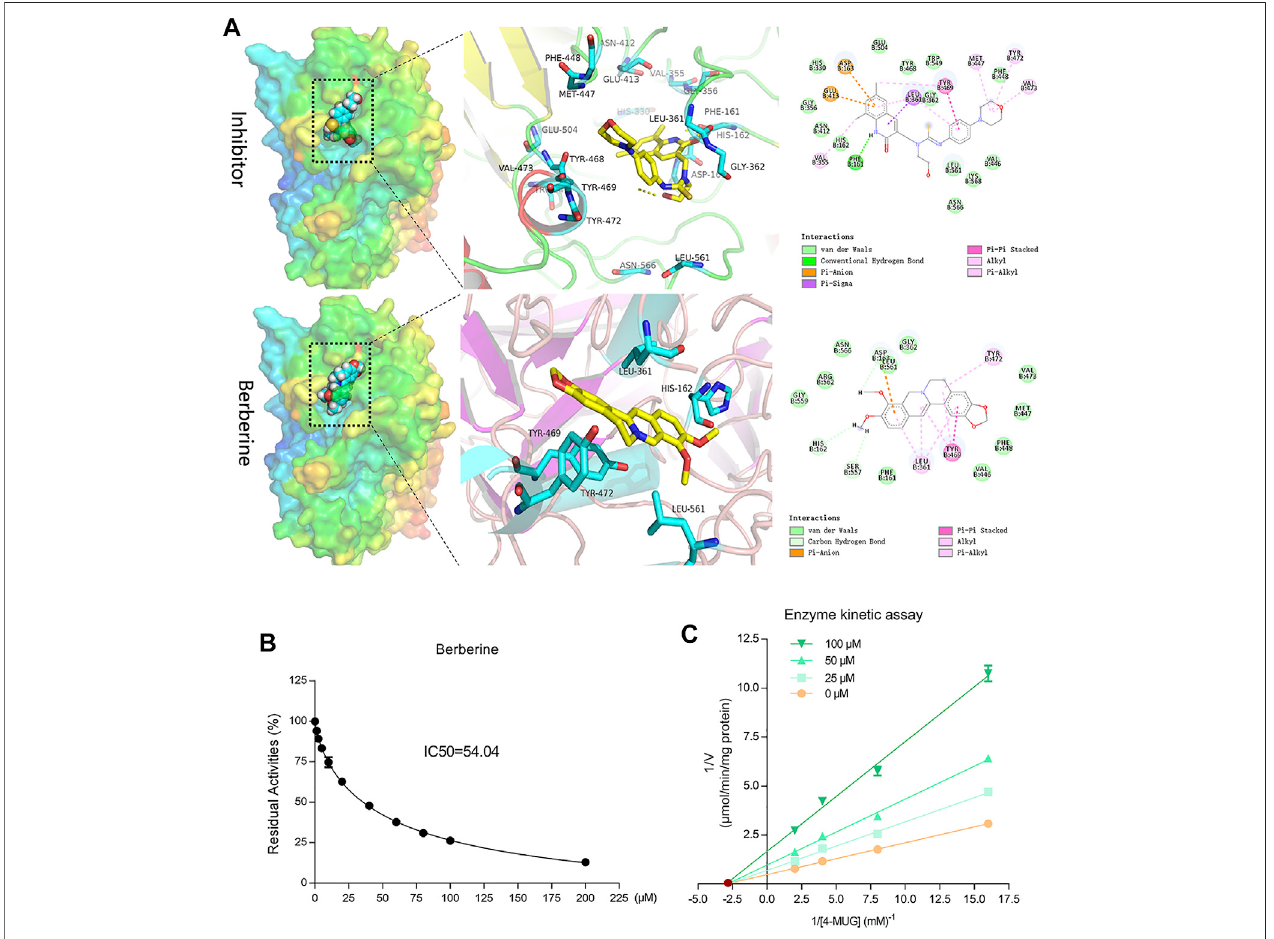
FIGURE 6 | Berberine inhibited GUS enzyme in a non-competitive manner. (A) Active site interactions for berberine or inhibitor-bound E. coli GUS. (B) Berberine inhibited GUS activities in a dose-dependent manner. (C) Lineweaver-Burk plots for berberine against GUS.